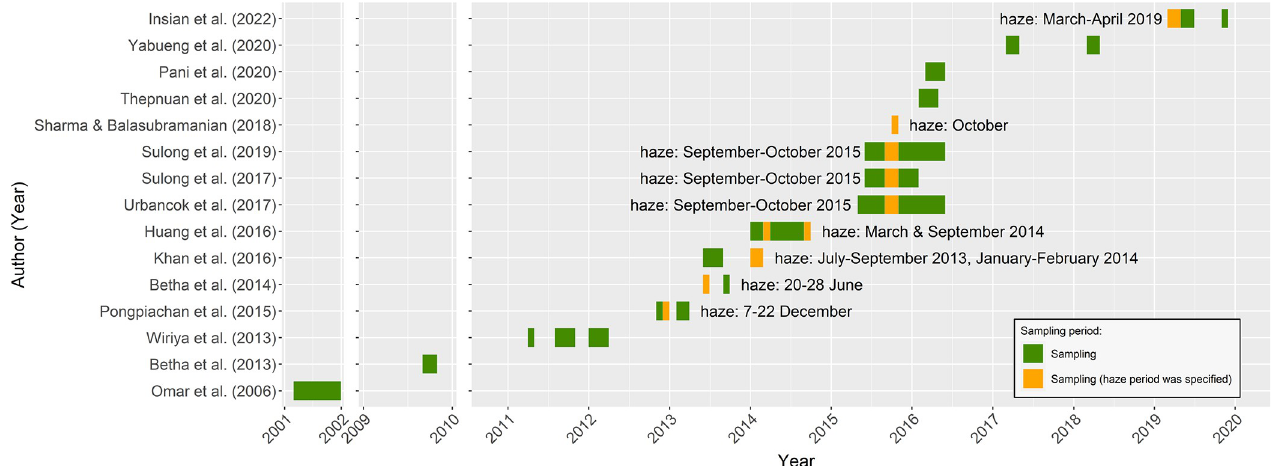
Fig 5. Timeline of sampling period and haze period in health risk assessment studies in Southeast Asia. Green indicates sampling period. Yellow indicates haze period specified within the sampling period.